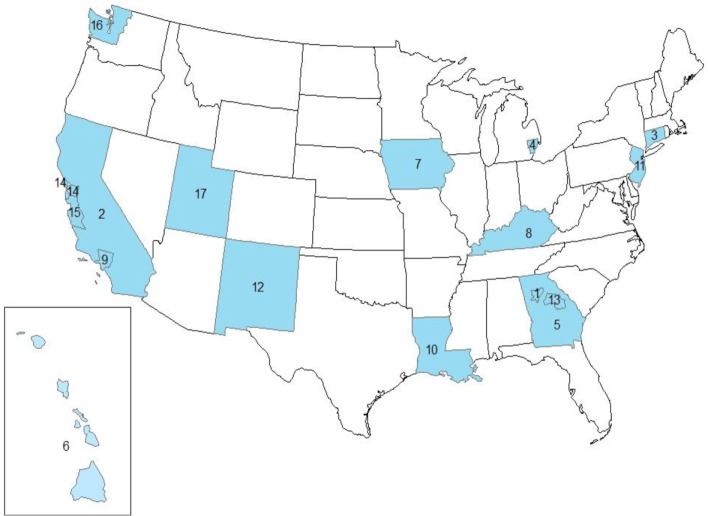
Study area showing the SEER17 registries, excluding Alaska. 1. GA-ATL, Atlanta (Metropolitan). 2. CA-OTH, California excluding CA-SF and CA-SJ. 3. CT, Connecticut. 4. MI-DET, Detroit (Metropolitan). 5. GA-OTH, greater Georgia. 6. HI, Hawaii. 7. IA, Iowa. 8. KY, Kentucky. 9. CA-LA, Los Angeles. 10. LA, Louisiana. 11. NJ, New Jersey. 12. NM, New Mexico. 13. GA-RUR, rural Georgia. 14. CA-SF, San Francisco-Oakland SMSA. 15. CA-SJ, San Jose-Monterey. 16. WA-SEA, Seattle (Puget Sound). 17. UT, Utah.